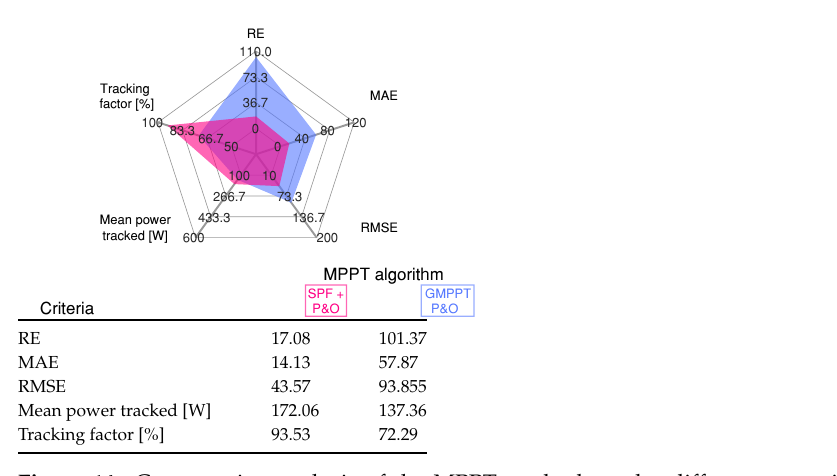
Figure 14. Comparative analysis of the MPPT methods under different nonuniform irradiance conditions for Scenario 5 shown in Figure